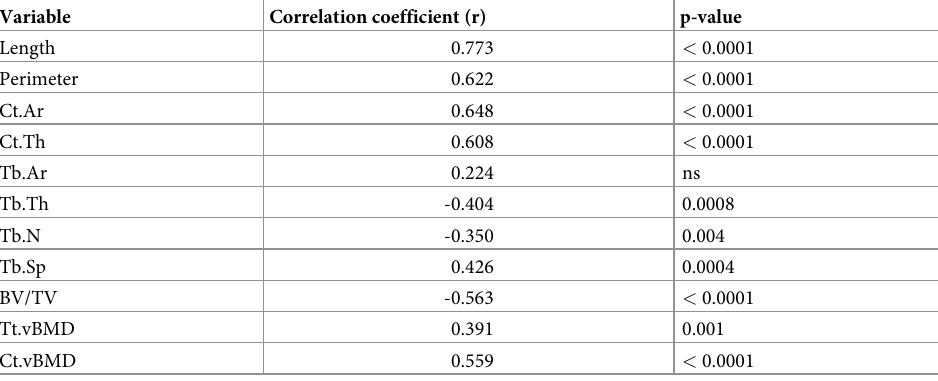
Table 2. Results of correlation analysis (Pearson’s product-moment correlation coefficient and its significance) between age (range 0.5 to 23 months) and size, microarchitectural and bone mineral density variables of the man- dibles of juvenile harbor seals, Phoca vitulina (age range: 0.5 to 23 months; n = 66); ns = not